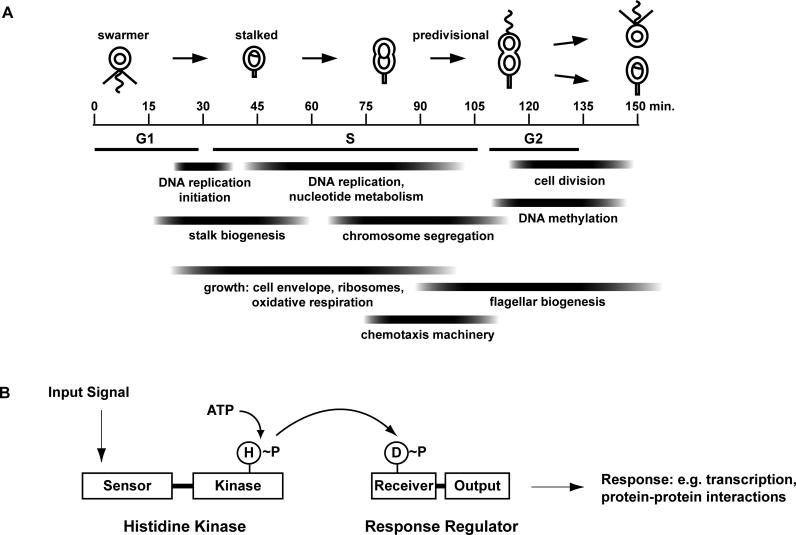
The C. crescentus Cell Cycle and Two-Component Signal Transduction(A) Schematic diagram of progression through the C. crescentus cell cycle, as described in the text. The timing of key cell cycle and developmental events are indicated. Cell division is asymmetric, generating two distinct daughter cells. The stalked cell can immediately initiate DNA replication, whereas the swarmer cell must first differentiate into a stalked cell.(B) Diagram of a canonical two-component signal transduction system. On receipt of an input signal, the histidine kinase autophosphorylates on a conserved histidine residue. The phosphoryl group is then passed to the receiver domain of a cognate response regulator. Phosphorylation of the receiver domain typically activates the output domain, which can execute a variety of cellular tasks including initiating programs of gene expression, catalyzing metabolic reactions, or modifying protein–protein interactions.